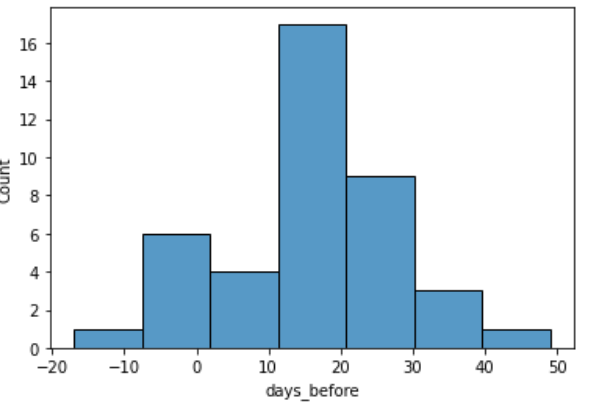
Figure 13. Histogram represents the difference in days between XGBoost weather model spike and the actual disease observation. A negative value represents the spike occurring after the first disease